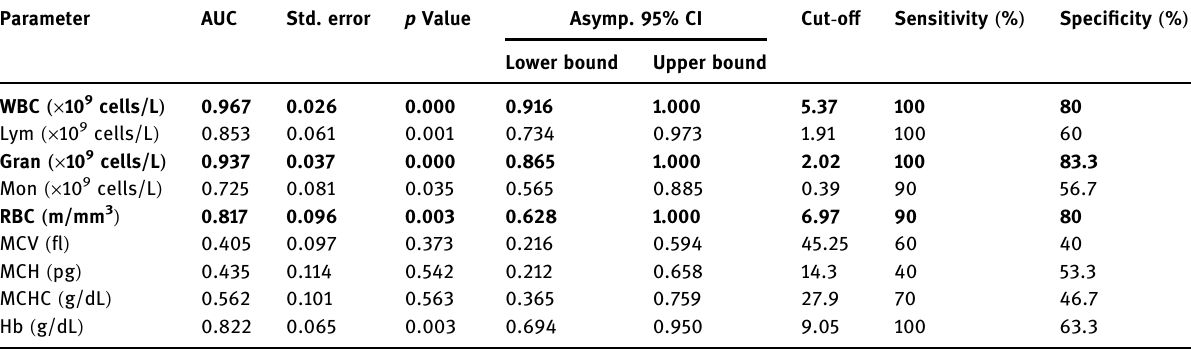
Table 9: Hemogram fi ndings